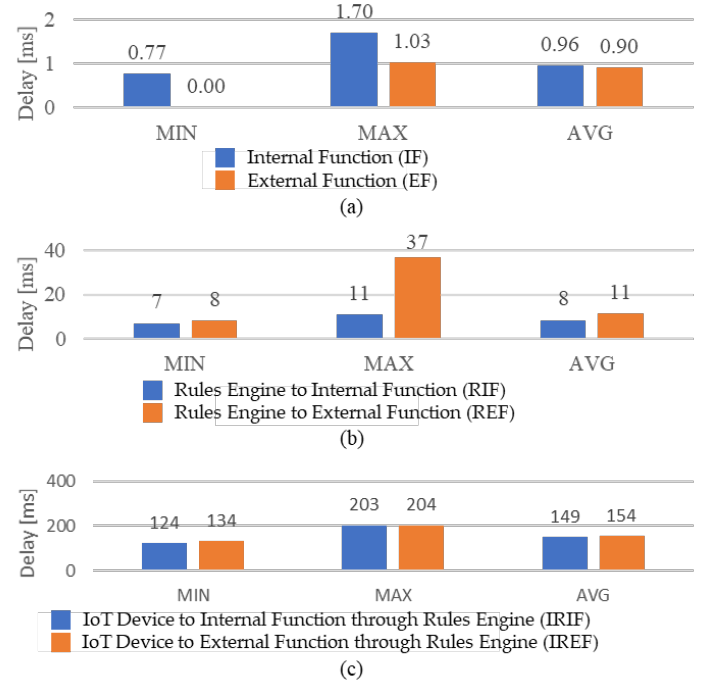
Figure 17. Performance of request delays for intelligent operation. ( a ) Operating intelligent function time. ( b ) Invoking intelligent function time. ( c ) Total operation time.